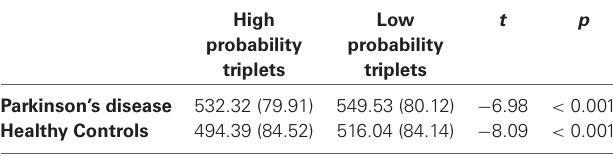
Table 2 | Mean of median reaction time for each Triplet type by Group .